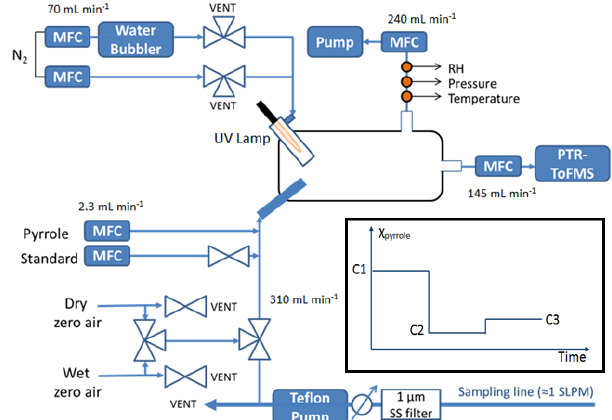
Figure 1. Schematic of the comparative reactivity method instru- ment developed at Mines Douai. Flow rates of different gases in- jected inside the CRM reactor (pyrrole, N 2 , air) or extracted from the reactor (PTR-MS sampling, reactor exhaust) are shown. The in- sert displays the measurement sequence for pyrrole (C1, C2, C3) during OH reactivity